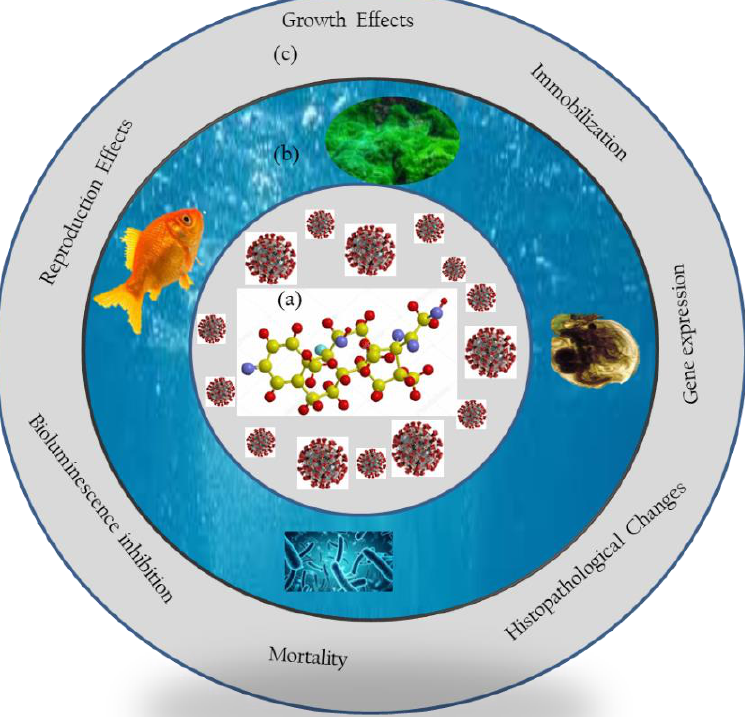
Figure 2. Schematic representation of ( a ) DEXA used for treating COVID-19, with likely interactions to ( b ) aquatic organisms at different levels of organizations, resulting in ( c ) the induction of diverse toxicological outcomes, including whole-body to molecular and cellular